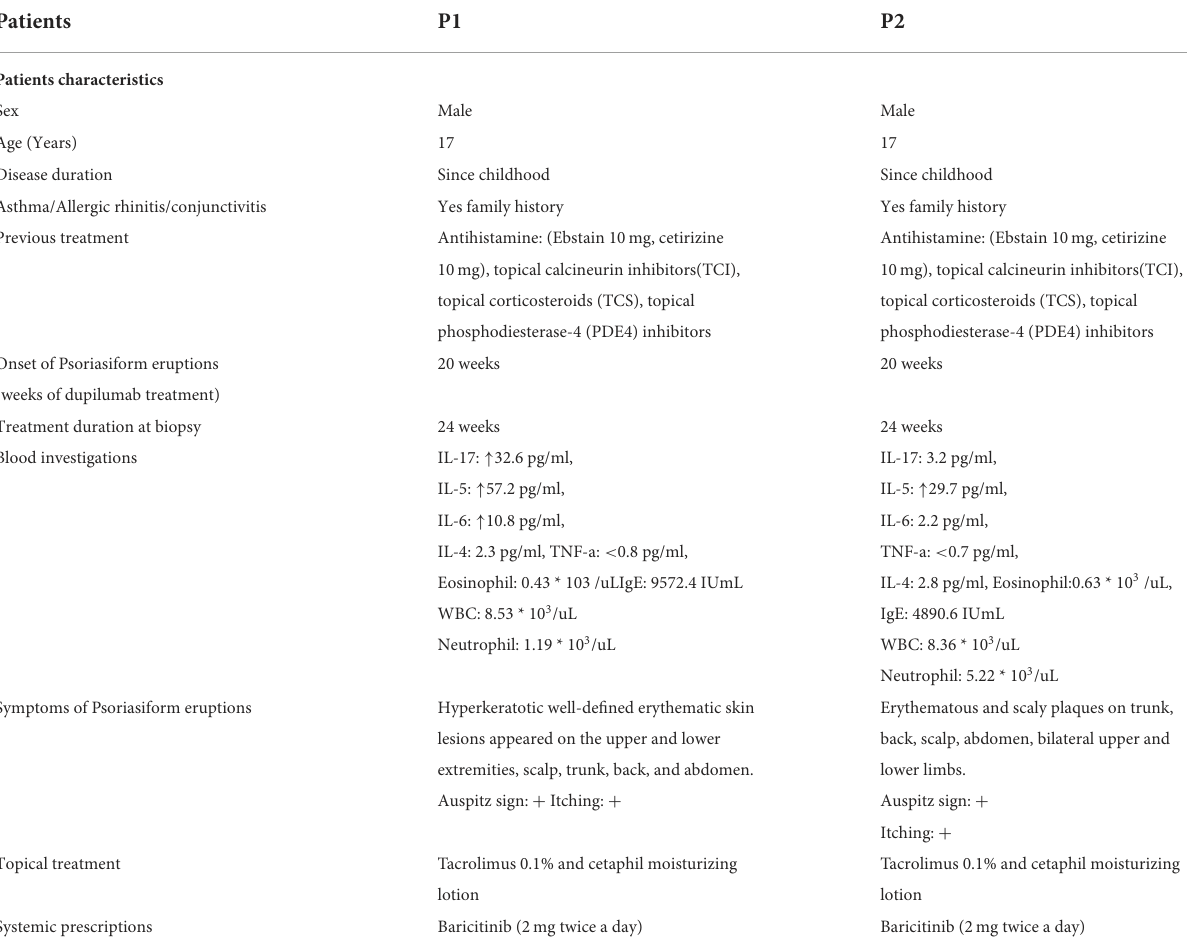
TABLE 1 Patients and clinical features of atopic dermatitis with psoriasiform eruptions ( n = 2).